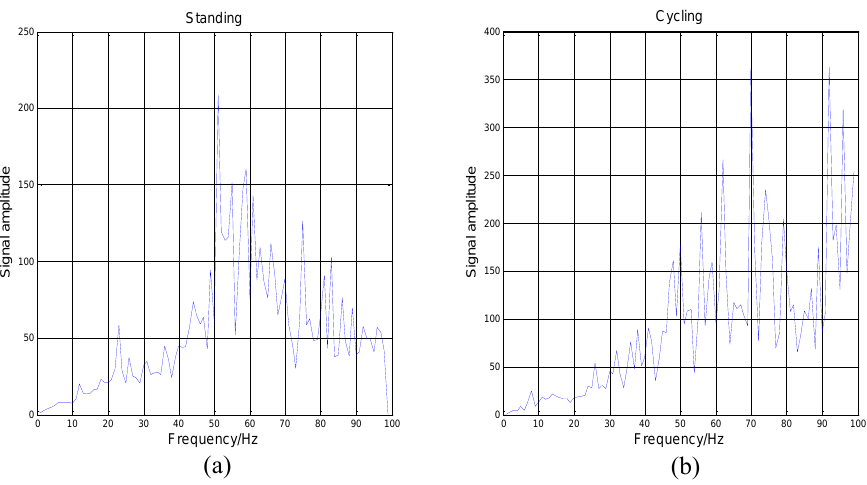
Figure 8. Degree of stationarity (DS) of two different types of activities. ( a ) The DS of standing data; ( b ) The DS of cycling data. All data come from the x-axis of the accelerometer on the wrist. The ordinate value represents the degree of non-stationarity of the